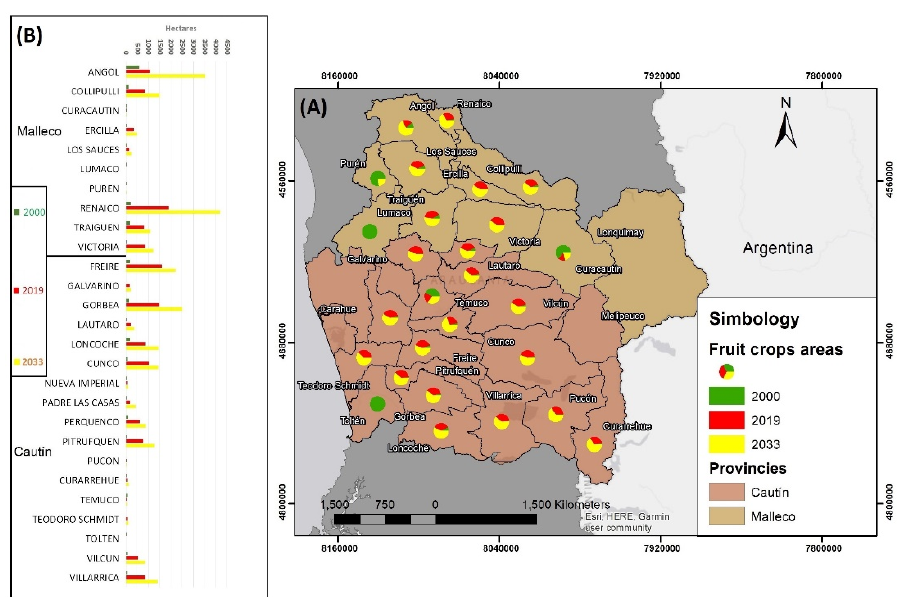
Figure 5. Fruit crop area by county in the Araucanía region in 2000, 2019, and 2033. ( A ) fruit crop area in hectares for each year, by county, in the Araucanía region. ( B ). Percentage of fruit crop area by county for the years 2000-2019-2033.